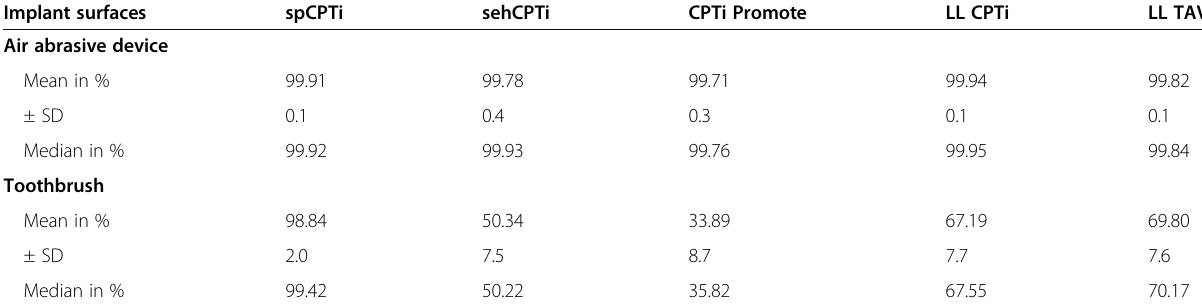
Table 2 Overview on mean clean implant surface ± standard deviations as well as medians after decontamination procedures (after 48 h biofilm formation) regarding the groups Implant surfaces spCPTi sehCPTi Air abrasive